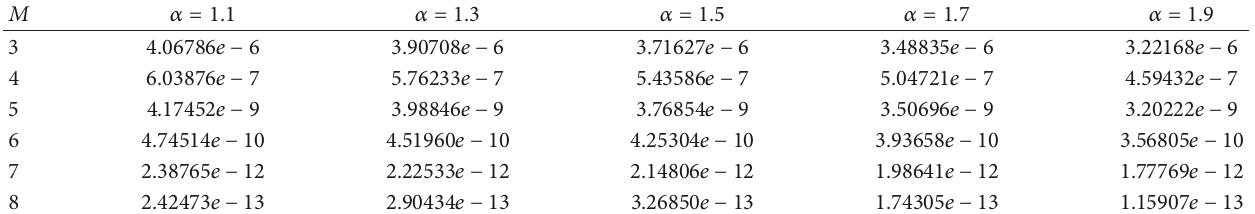
Table 5: Maximum absolute error for Example 2 with various choices of 𝑀 and 𝛼 .